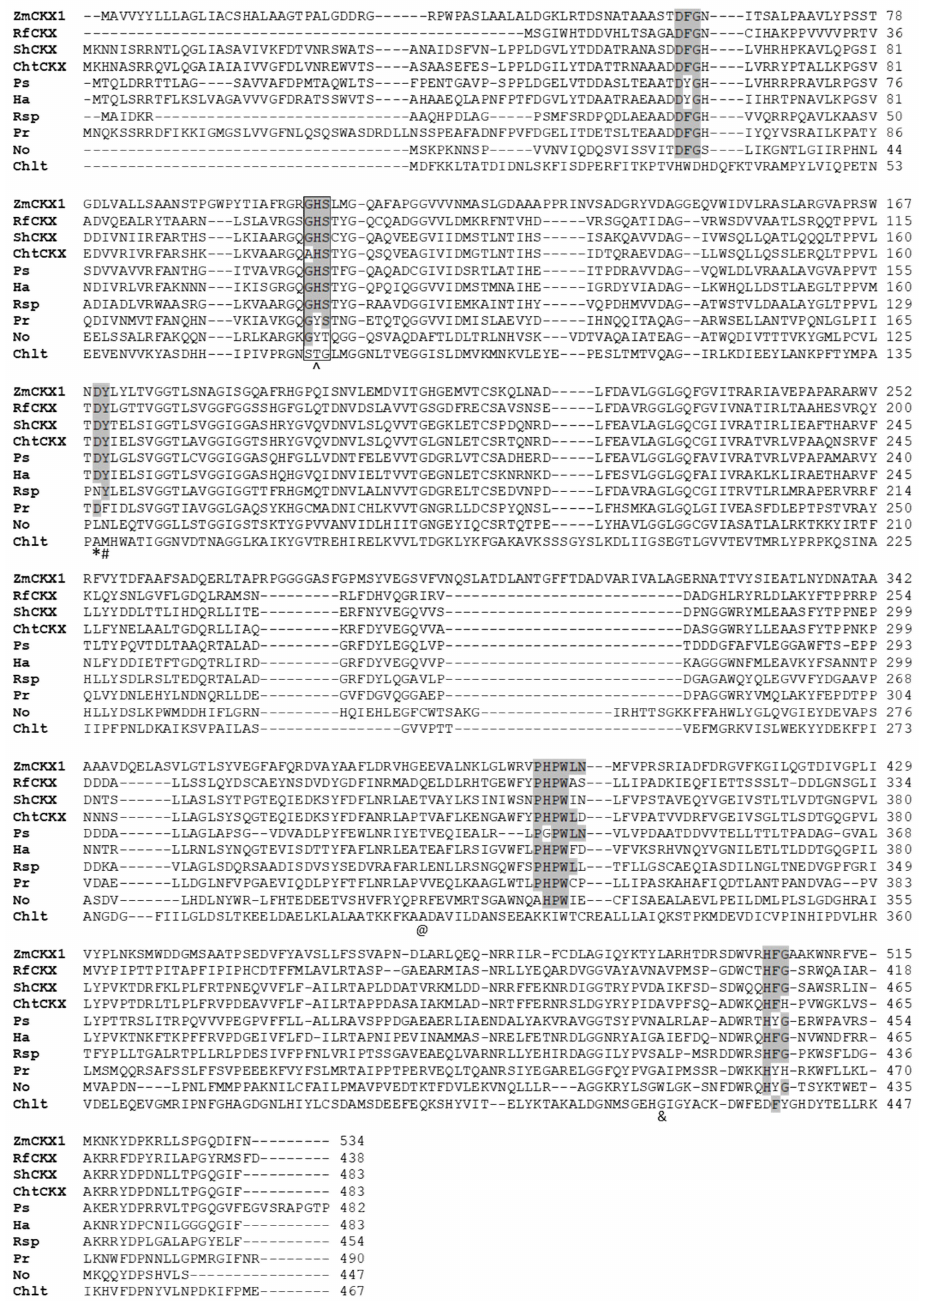
Figure 5. Amino acid sequence alignment of selected CKX and CKX-like proteins. Protein sequences were aligned using the ClustalW interface in BioEdit 7.2.5 [77]. Residues forming highly conserved motifs are highlighted in grey. The FAD-binding GHS motif is framed and the His residue forming the covalent bond with FAD is marked (ˆ). Residues involved in enzyme catalysis (*), covalent flavinylation (#), reactivity with N9 glucosides (@), and cZ (&) are indicated below the sequence. Numbers on the right indicate amino acid position in the respective protein. The selection of bacterial proteins is based on evolutionary analysis of CKXs by Wang et al. [29]. ZmCKX1, RfCKX, ShCKX, and ChtCKX are the abbreviations for proteins with confirmed CKX activity from the following organisms: maize (reference plant CKX of known crystal structure), Rhodococcus fascians D188 (Actinobacteria), Scytonema hofmanni PCC 7110 (Cyanobacteria), and Chroococcidiopsis thermalis PCC 7203 (Cyanobacteria), respectively. Other included CKX-like proteins are Ps from Promicromonospora sukumoe (Actinobacteria), Ha, Herpetosiphon aurantiacus DSM 785 (Chloroflexi), Rsp, Rhizobium sp. YS-1r (Proteobacteria), Pr, Pseudoalteromonas rubra (Proteobacteria), No, Nostoc sp. PCC 7120 (Cyanobacteria), and Chlt, Chlamydia trachomatis